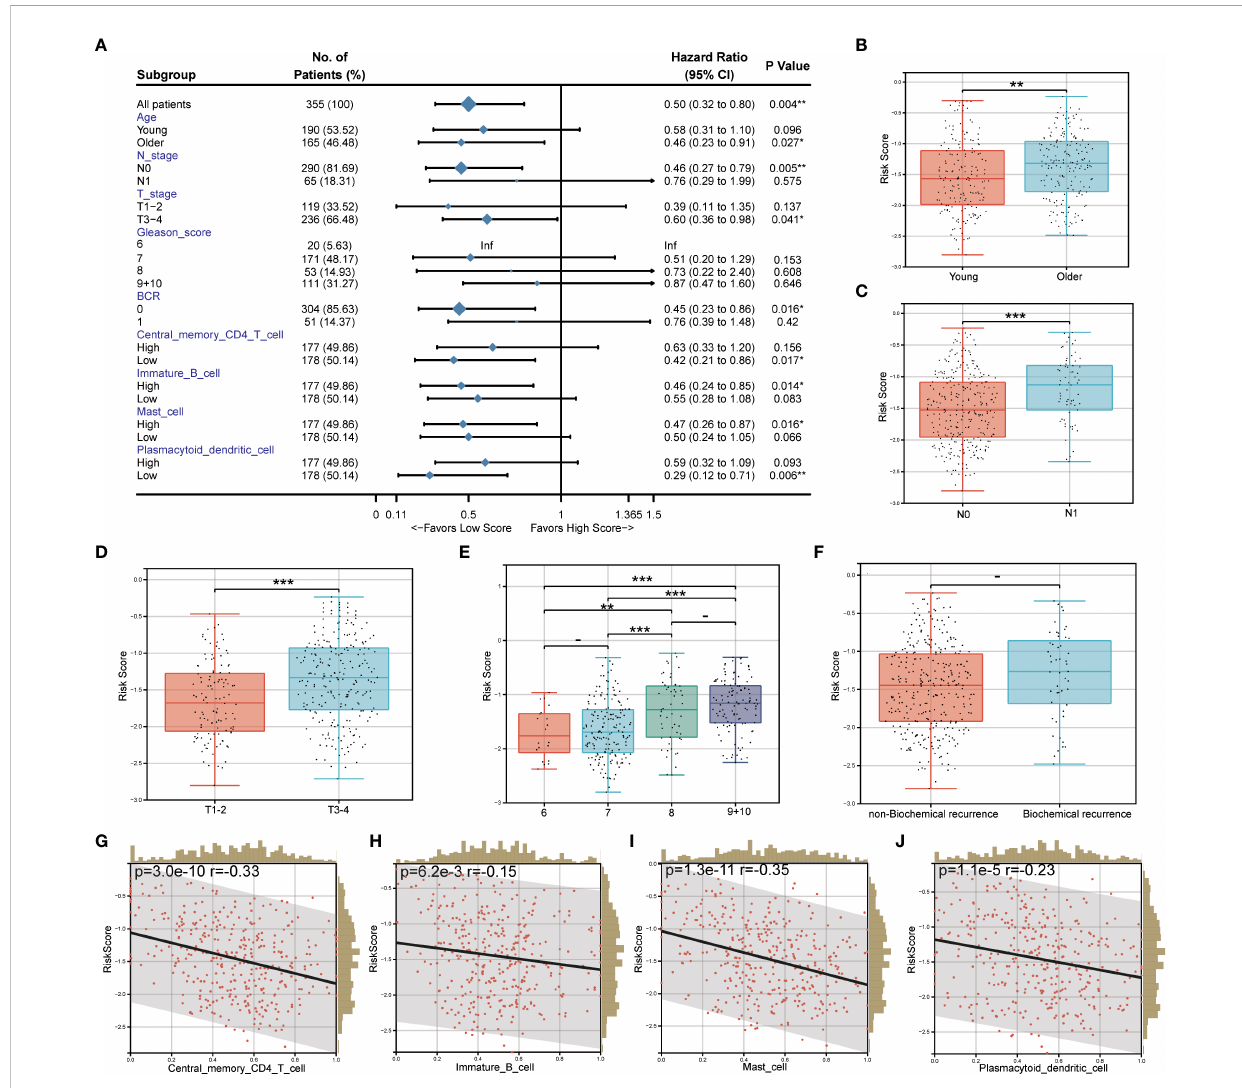
FIGURE 7 Correlation between prognostic risk score and clinical/immune characteristics. (A) Univariate Cox regression analysis of prognostic risk score and clinical feature subgroup/four kinds of immune cells; (B – F) . Differences in prognostic risk scores among clinical feature subgroups; (G – J) . Correlation between four kinds of immune cells and prognostic risk score. * P < 0.05; * * P < 0.01; *** P < 0.001. -: no relevant